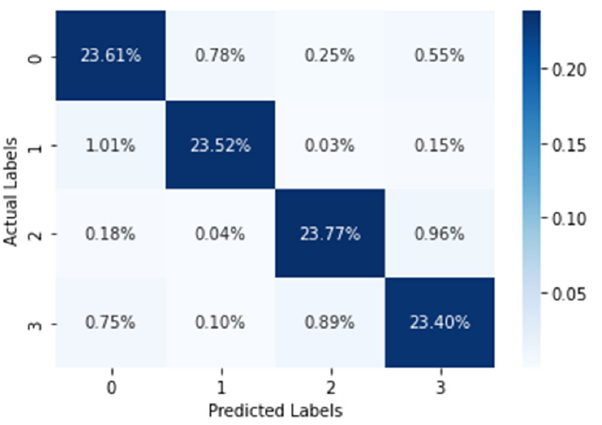
Figure 6. Confusion matrix generated by the proposed image-encoding-based deep neural network for the WESAD dataset where the percentage of data are being displayed in each quadrant. Table 2. Performance of our proposed image-encoding-based deep neural network model for class- wise accuracy of WESAD dataset with different stress